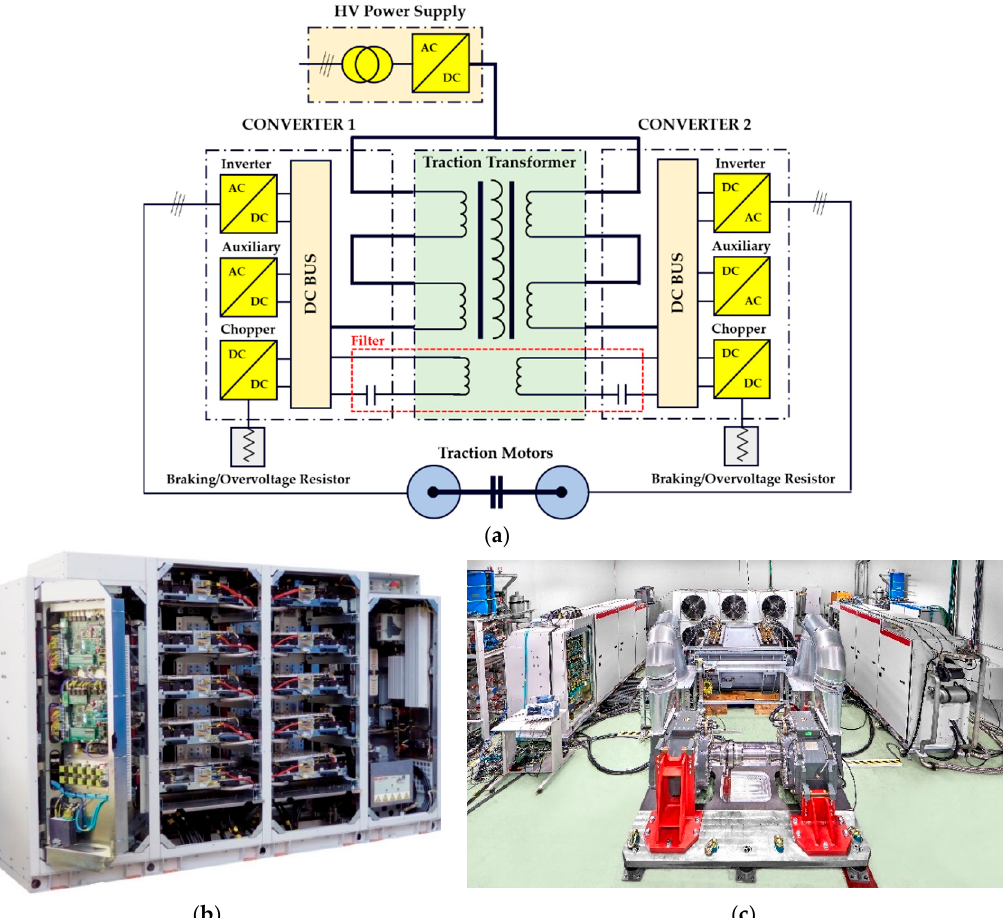
Figure 20. High-power traction test bench: ( a ) Schematic diagram; ( b ) power converter module (INGETRAC); and ( c ) overall view of the laboratory setup.